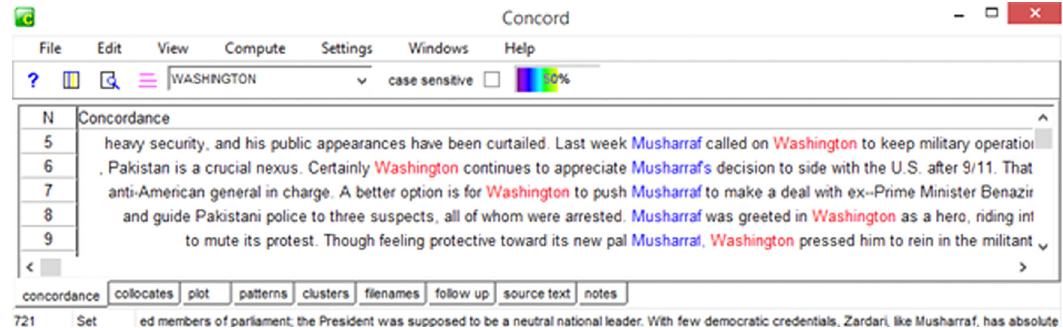
Fig. 8 Concordance extract. Concordance extract Washington-Musharraf*